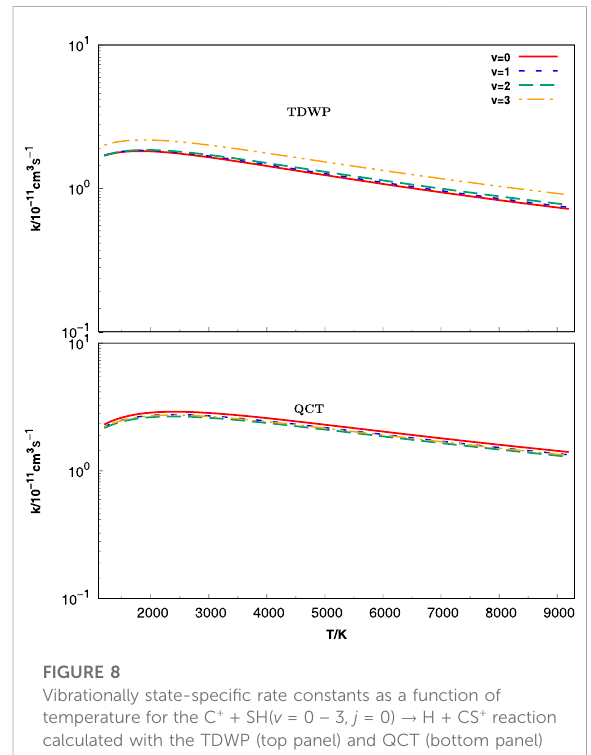
FIGURE 8 Vibrationally state-speci fi c rate constants as a function of temperature for the C + + SH( v = 0 − 3, j = 0) → H + CS + reaction calculated with the TDWP (top panel) and QCT (bottom panel)